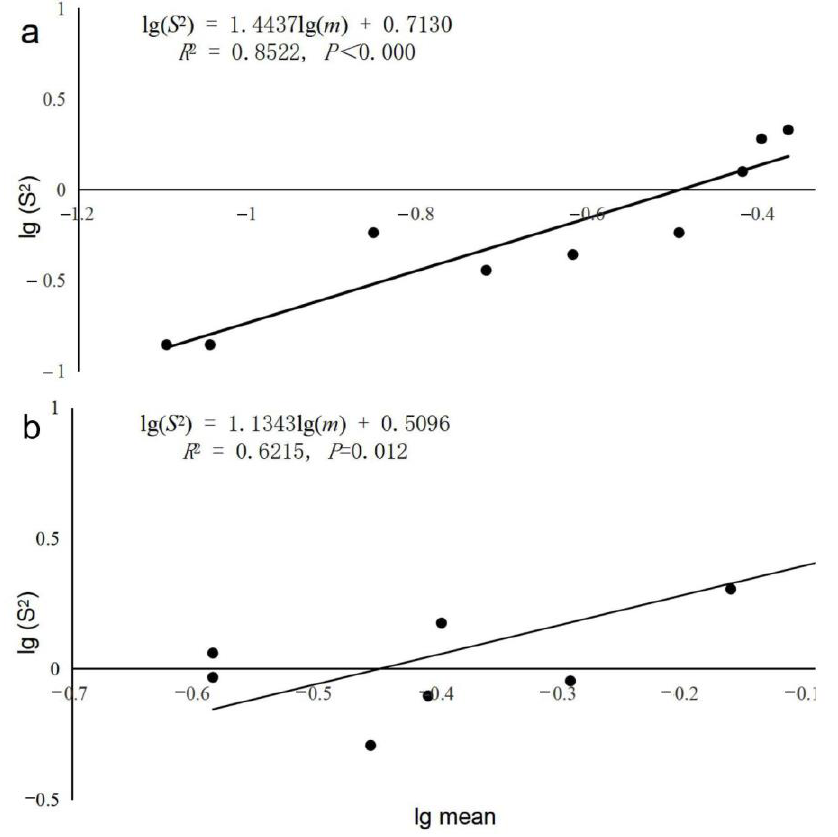
Figure 1. Linear relationship between the field variances and means of Tomicus minor ( a ) and Tomicus yunnanensis ( b ) infested Pinus yunnanensis collected at all experimental sites during the shoot-feeding phase with Taylor’s power law regression from 2016 to 2018.